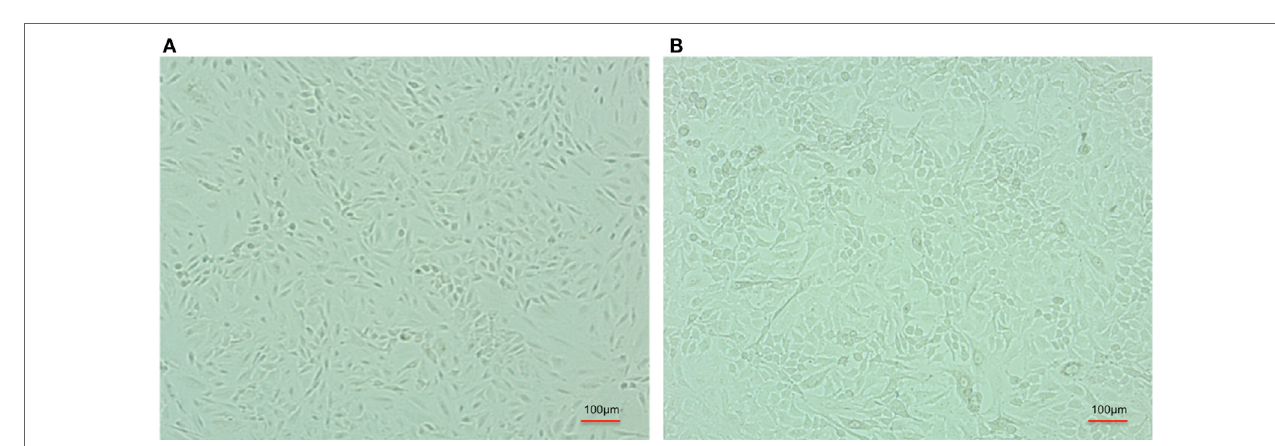
FigUre 2 | Comparative cell line image of A-549 cell line in the absence (a) and coinfected with carbapenem-resistant strain, RS 307 of Acinetobacter baumannii (B) . The experiments were performed in quadruplet. Infection leads to the lysis of A-549 cell.